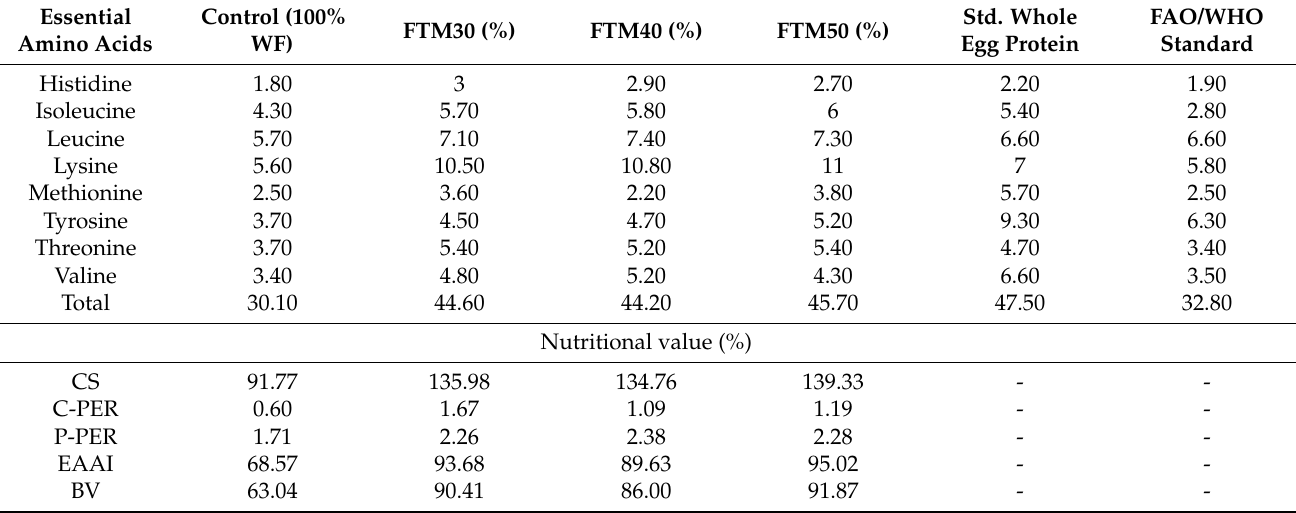
Table 2. Amino acid composition in the prepared noodles 1 .